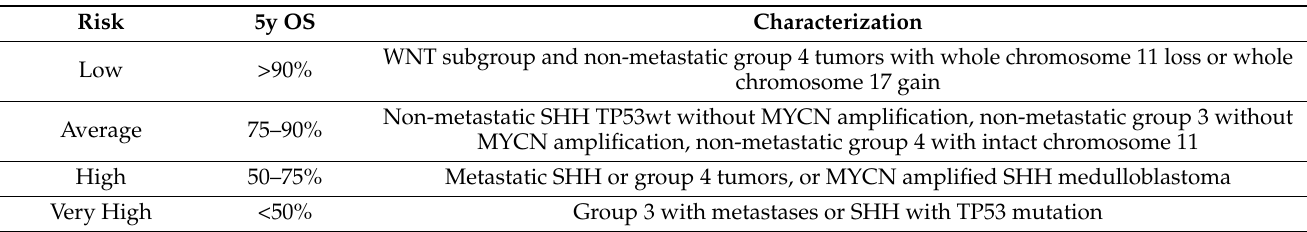
Table 4. Molecular based risk groups in